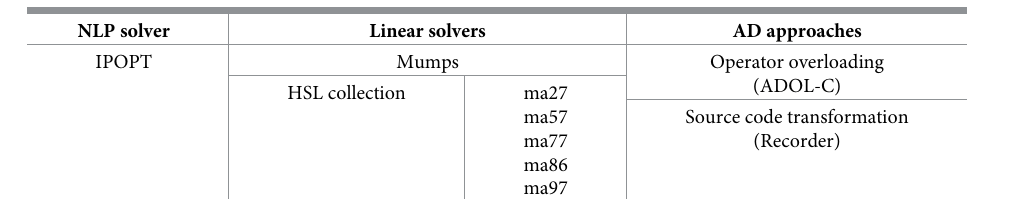
Table 4. Numerical